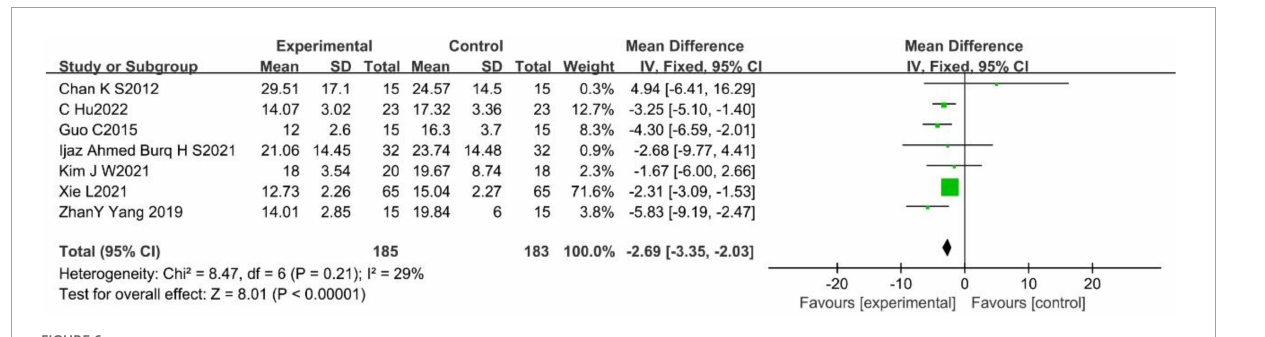
FIGURE6 Forest plot of the effects of WBV training on